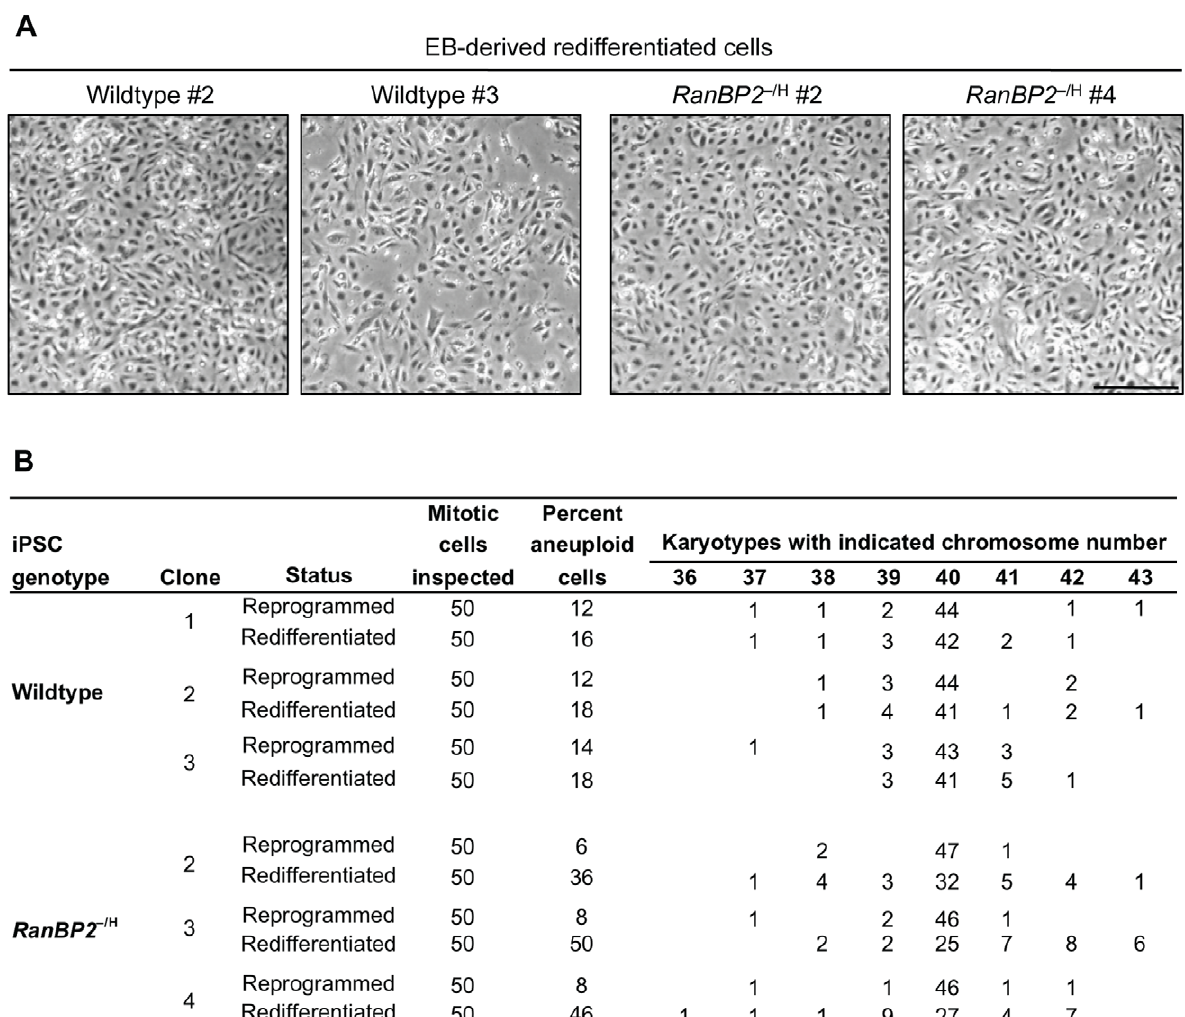
Figure 4. RanBP2 hypomorphic iPSCs reestablish W-CIN after redifferentiation. (A) Light microscopy images of cell cultures derived from EBs with indicated genotypes. Scale bar represents 500 m m. (B) Chromosome counts on EB-derived cells paired with the karyotype of the parental iPSC clone from Table 2.